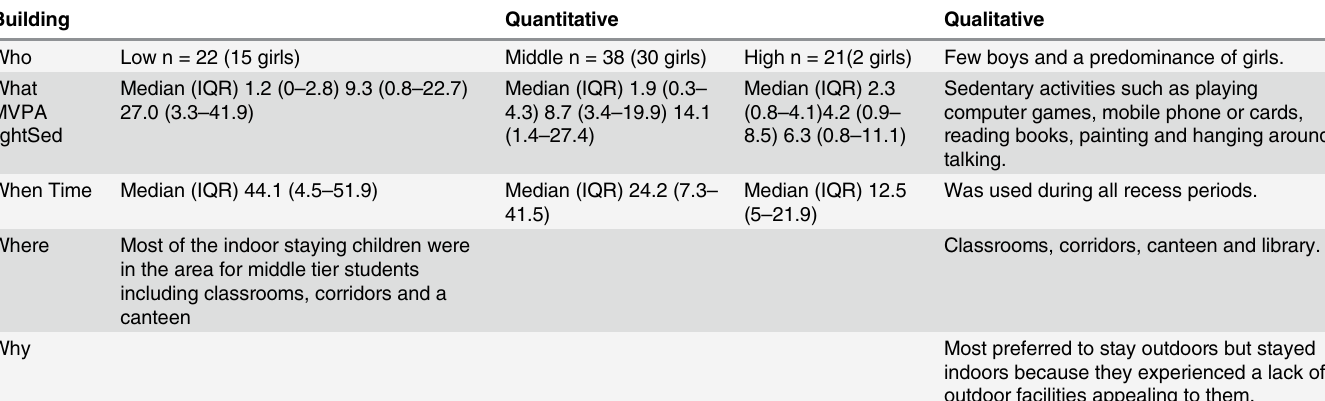
Table 1. Characteristics of time spent, activity level and behavior in the building during recess. Building Quantitative